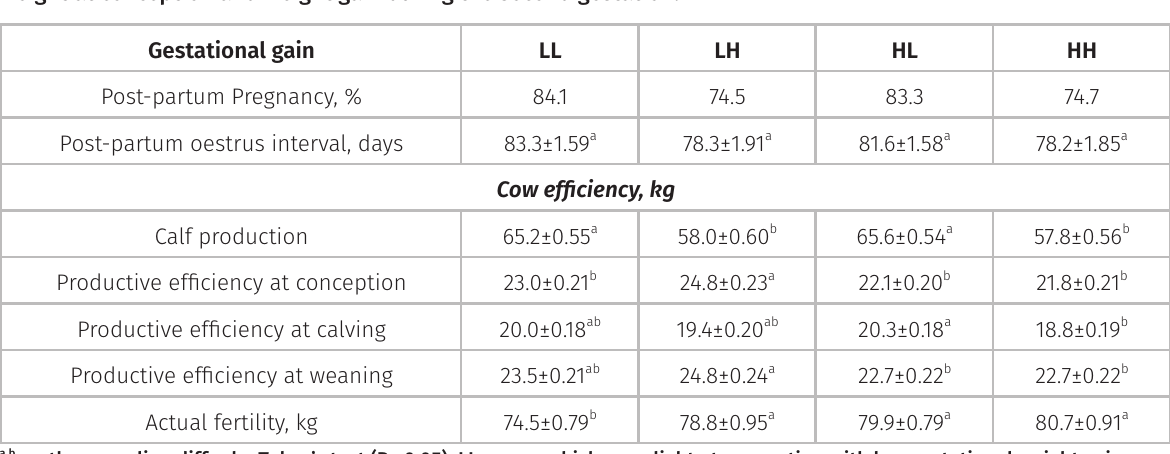
Table II. Mean values and standard errors for efficiency variables in cow herds according to primiparous cow weight at conception and weight gain during the second